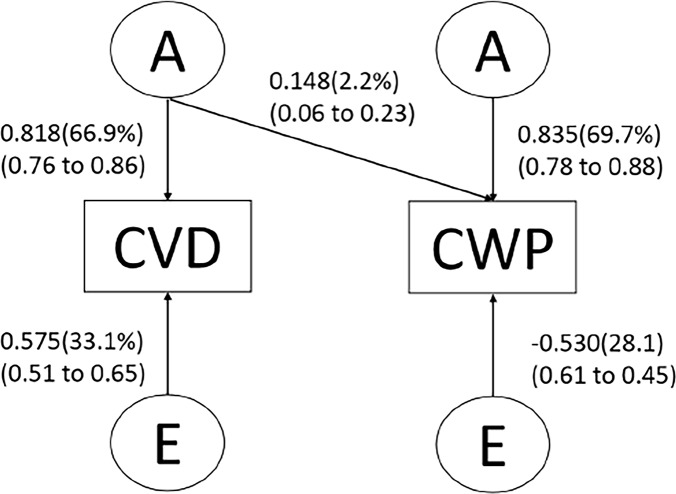
Path diagram of the Cholesky model for the covariance between chronic widespread pain (CWP) and cardiovascular disease (CVD) with adjustment for age.